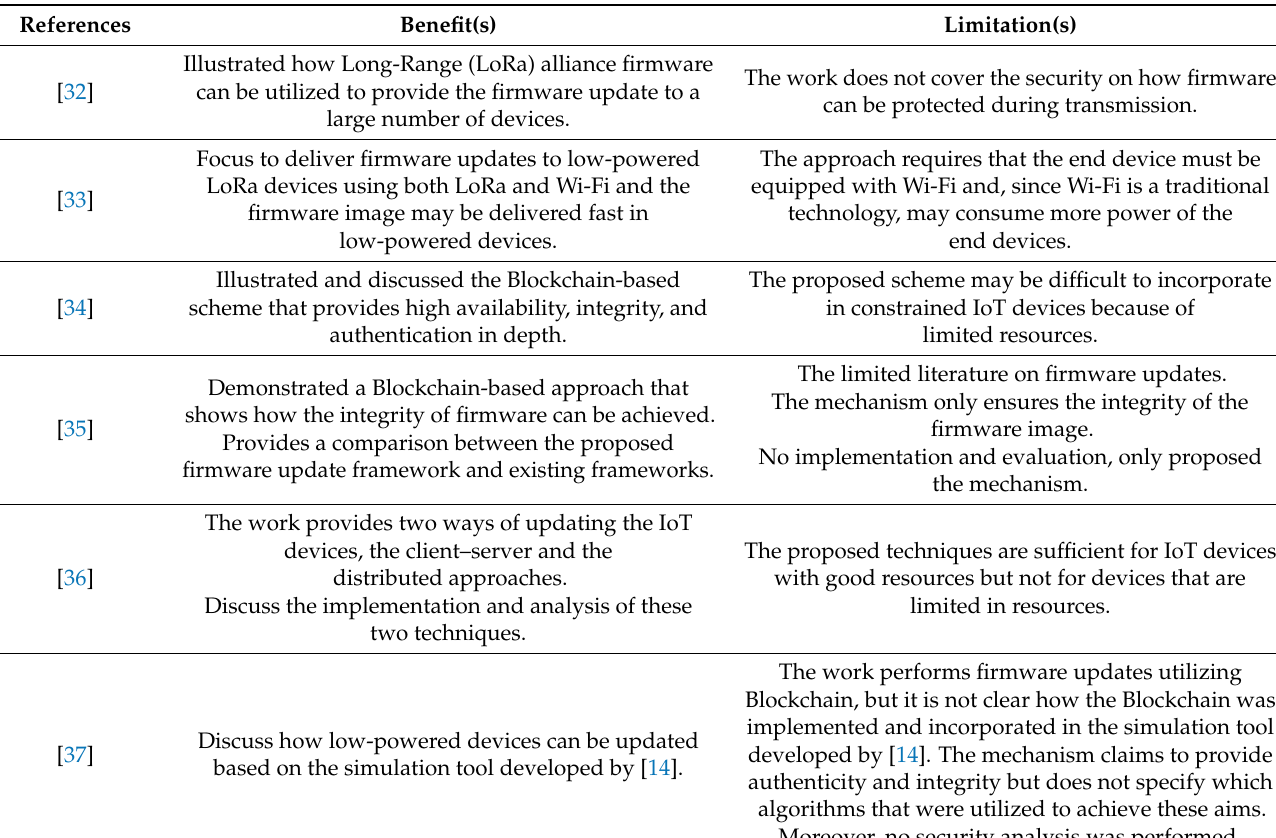
Table 2. Benefits and Limitations of the Firmware Update